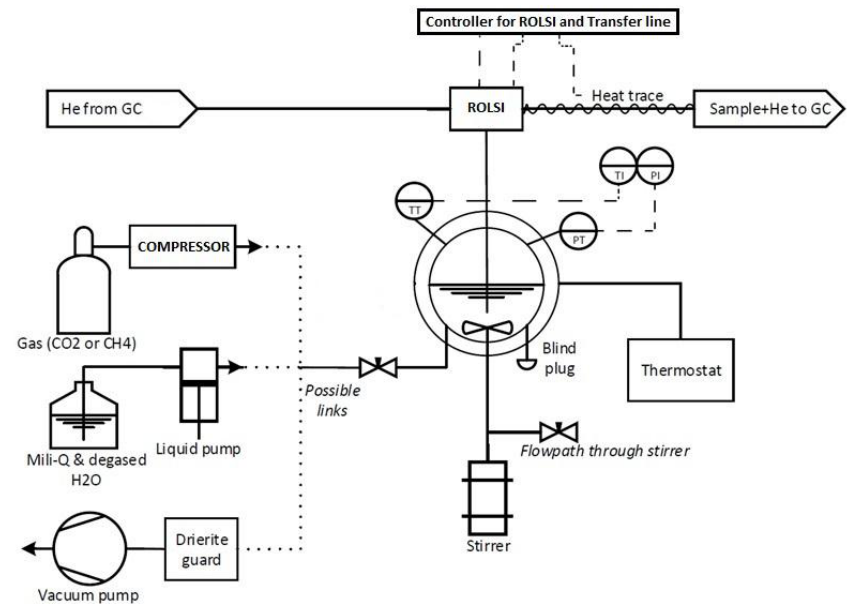
Figure 2. Sketch of the experimental set-up including the high-pressure cell, modified from Ruffine et al. [42].